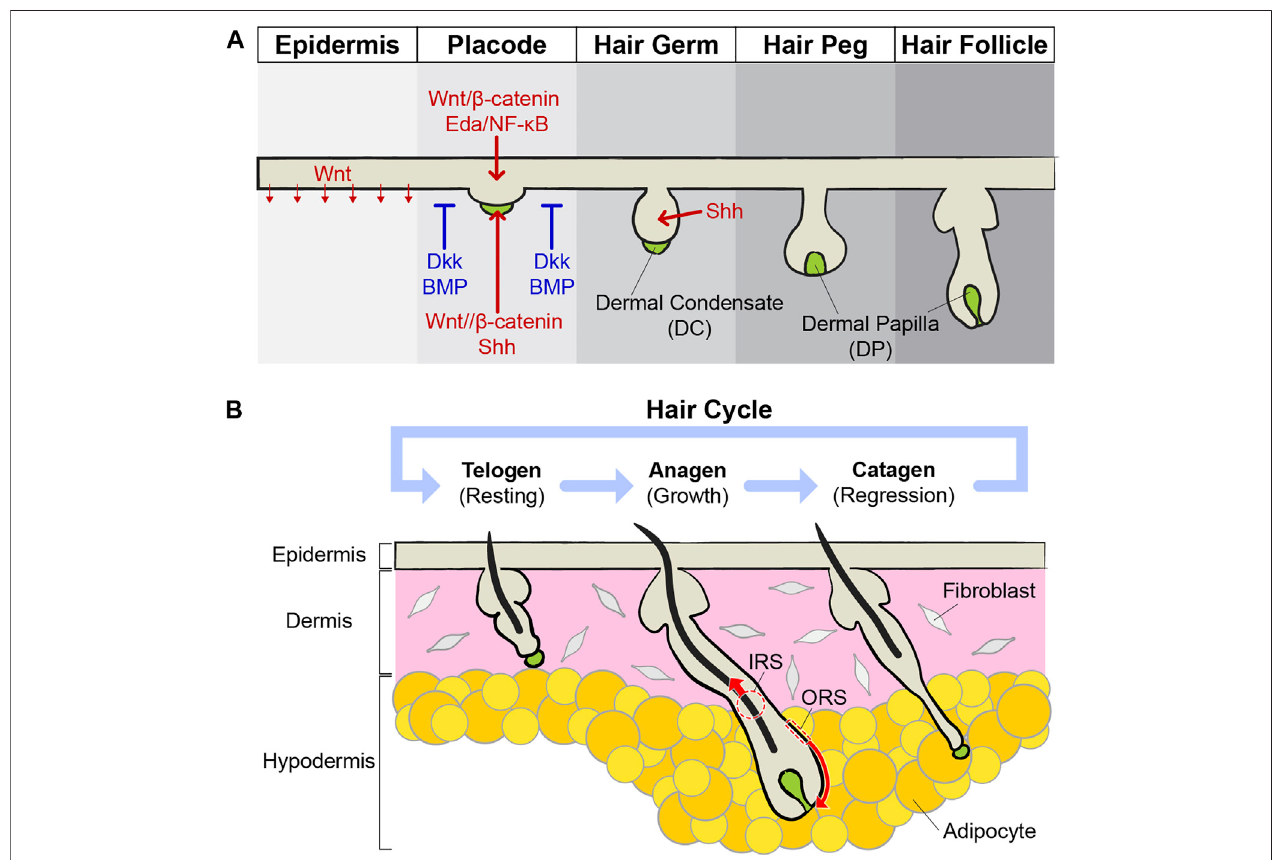
FIGURE 1 | Development and cycling of hair follicles. (A) During embryonic development, the skin epithelium differentiates and generates hair follicles. Epithelial cells in the epidermis are thickening to build a placode, and mesenchymal cells in the dermis gather to form a dermal condensate (DC) just below the placode. The placode and DC exchange growth signals, such as Wnt/ β -catenin and Shh, with each other and grow downward. Around the placodes, inhibitory signals, such as Dkk and BMP, suppress the expression of the hair follicles, thereby expressing the pattern of hair follicle arrays. Placode continuously develops into hair germ and hair peg structures. DC becomes dermal papilla (DP) right below the hair follicles and acts as niches for HFSCs. Eventually, mature hair follicles are formed prenatally. (B) Mature hair follicles undergo cycles of growth (anagen), regression (catagen), and resting (telogen). During the anagen, stem cells become activated by the surrounding niche components. Activated stem cells grow by repeating division, and their progenies differentiate to produce hair. When the anagen stops, the hair follicles enter the catagen phase. Through apoptosis of the outer root sheath (ORS) and extrusion of the inner root sheath (IRS), hair follicles become short in a few days. During the telogen, stem cells in the hair follicles are maintained in quiescence by inhibitory signals. When telogen is fi nished, stem cells are activated and the anagen starts again.